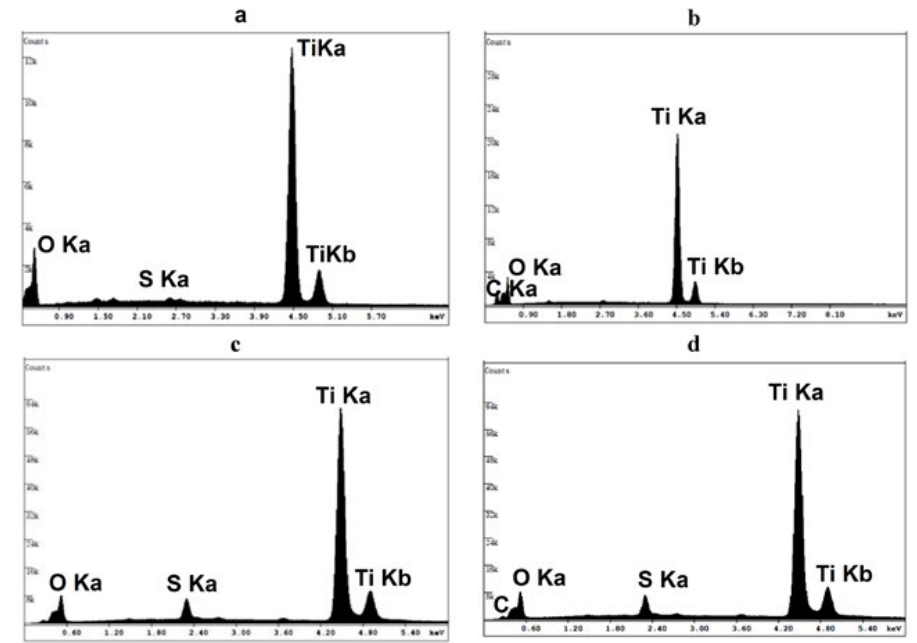
Fig. 4. EDAX of anatase (a) TiO